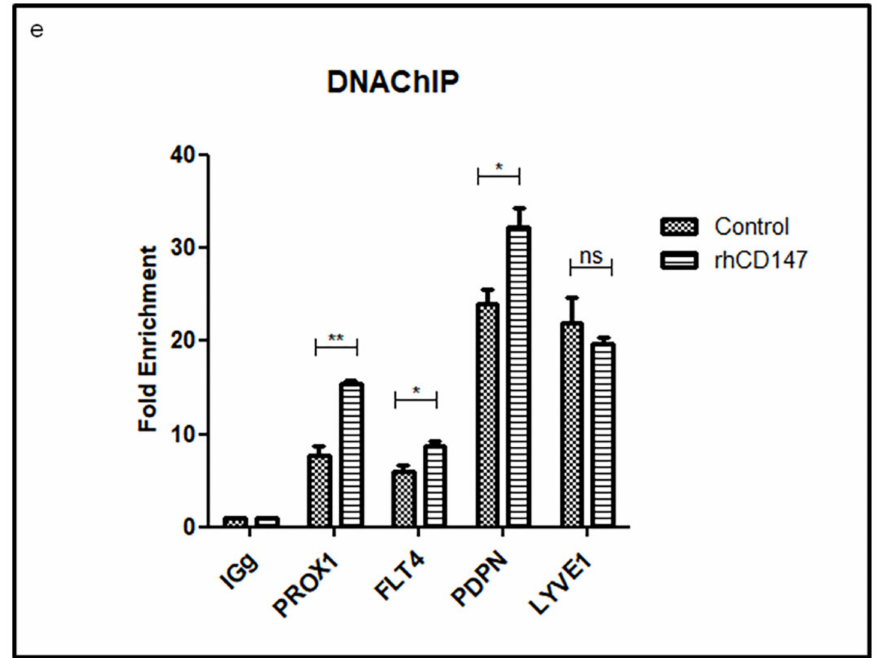
Figure 3. CD147 regulates LECs lymphangiogenic markers at transcriptional and translational levels. ( a ) qRT-PCR of FLT4 , PROX1 , LYVE1 , and PDPN expression in LECs treated or not with rhCD147, using PPIA as a reference. Columns indicate the means of three independent experiments carried out in triplicate; bars indicate SD; * p < 0.05, ** p < 0.005, *** p < 0.0001. ( b ) Western blot analyses of VEGFR-3, PROX-1, LYVE-1, Podoplanin, and CD147 expression in total lysates of LECs treated or not with rhCD147. ( c ) Three independent Western blots were quantified for densitometry band analyses. Equal loading of proteins was assessed by probing for β -actin. Bars, SD; * p < 0.05, ** p <0.005, *** p < 0.0001. ( d ) Representative confocal images of PROX-1, LYVE-1 and Podoplanin immunofluorescent staining on LECs treated or not with rhCD147 (63X magnification). Scale bar: 30 µ m. ( e ) ChIP-qPCR was performed on LECs treated or not with rhCD147, with antibody against PROX-1 total and control IgG. Columns indicate means of two independent experiments; and bars, SD; ns, non significant, * p < 0.05, ** p < 0.005, *** p <